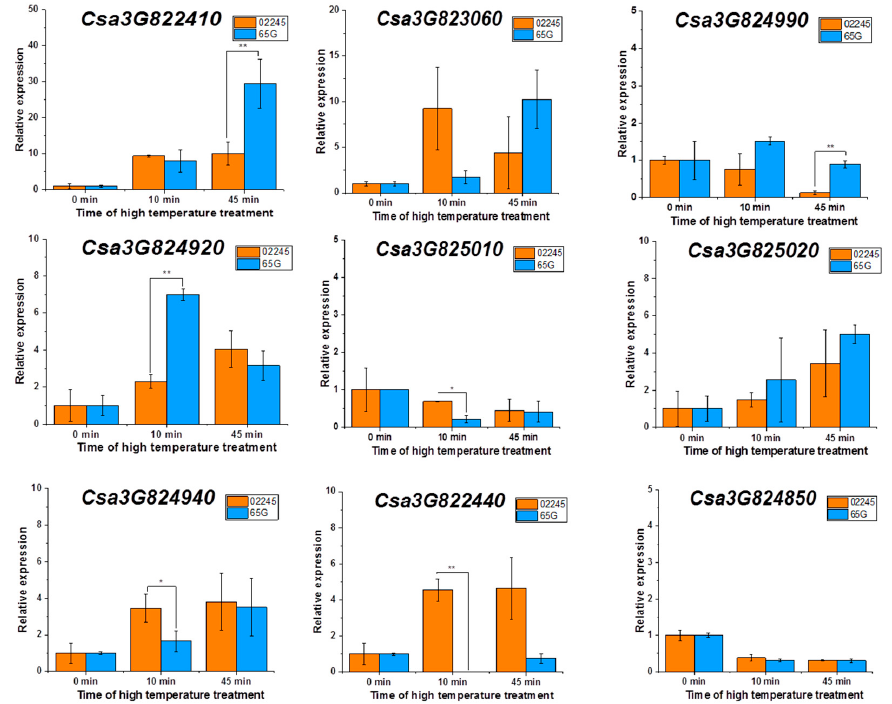
Figure 4. Quantification of transcripts from the candidate genes involve in thermotolerance. The transcript levels of genes at 0 min were set as 1. The x-axis indicates the time after 50 °C heat stress exposure, the y-axis indicates the relative amount of gene transcripts at different time-points compared to 0 min. RNA samples were extracted from two-leaf-stage seedlings that were exposed to 50 °C heat stress for 0, 10, and 45 min. Error bars represent the standard deviation. The asterisks indicate that there were significant differences in transcript level between heat-tolerant cucumber line ‘02245’ and heat-sensitive cucumber line ‘65G’ (‘*’, 0.01< p <0.05; ‘**’, 0.001< p <0.01).